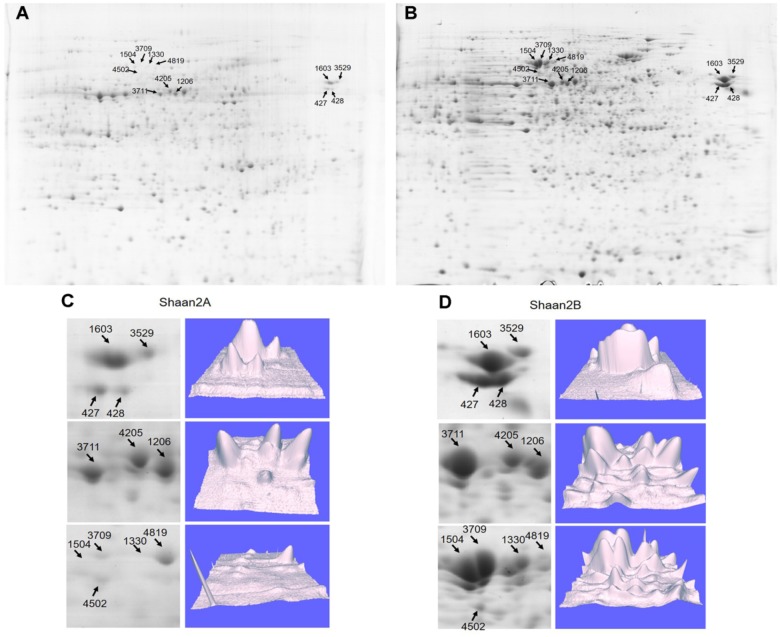
Representative images of DEPs between Shaan2A and Shaan2B. (A) Shaan2A 2-DE images. (B) Shaan2B 2-DE images. (C) Enlarged area of 2-DE gel and 3D images of Shaan2A. (D) Enlarged area of 2-DE gel and 3D images of Shaan2B.